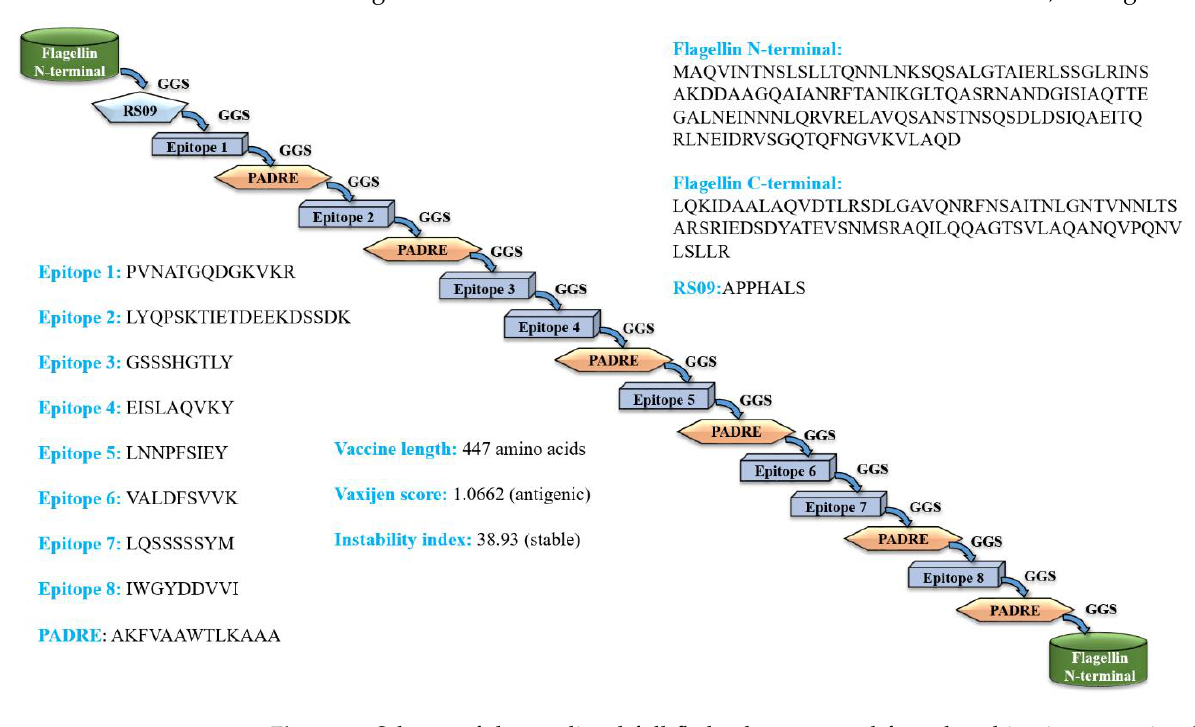
Figure 1. Scheme of the predicted full-fledged constructed fungal multi-epitope vaccine (MEV) construct. (PADRE = Pan HLA DR-binding epitope).